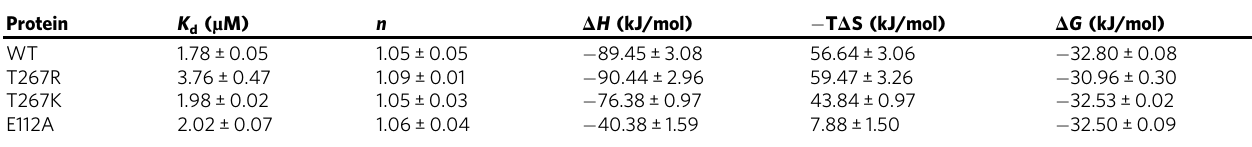
Table 3 Summary of thermodynamic parameters for ADP-ribose binding